Question: What visual encoding does this figure use to show its data?
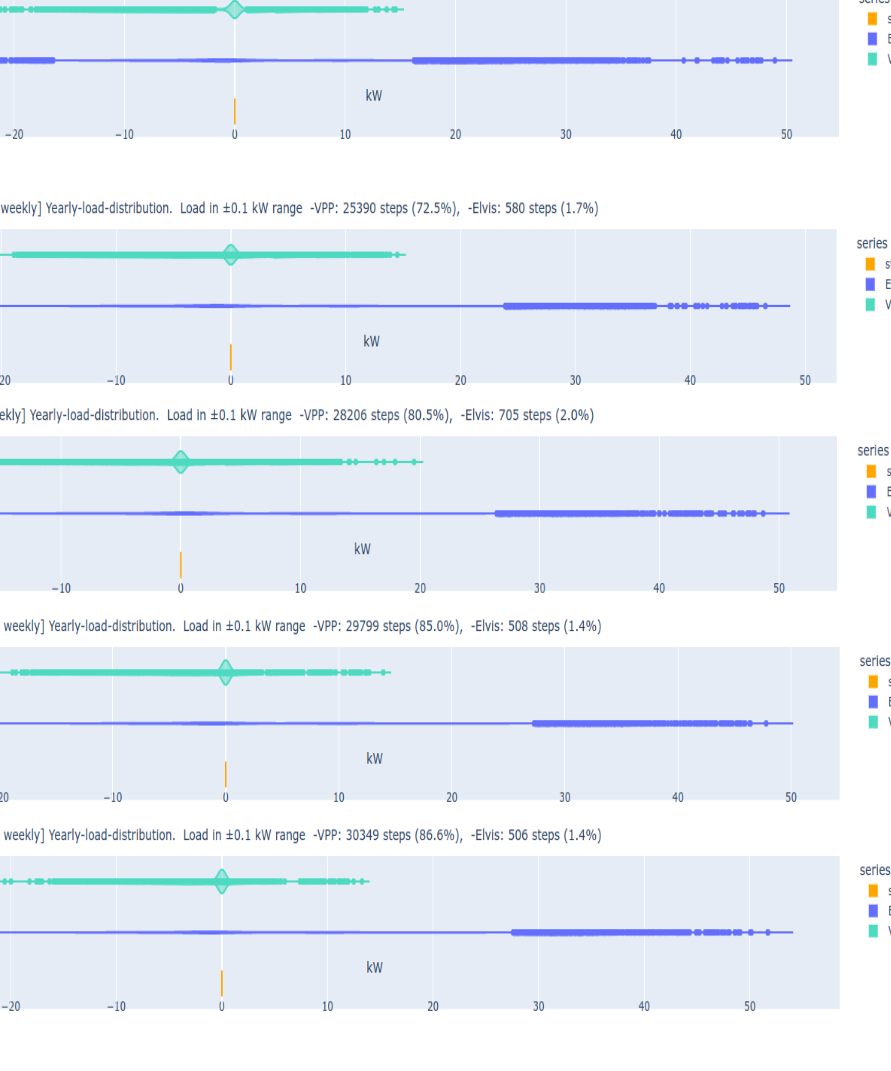
Answer: scatter